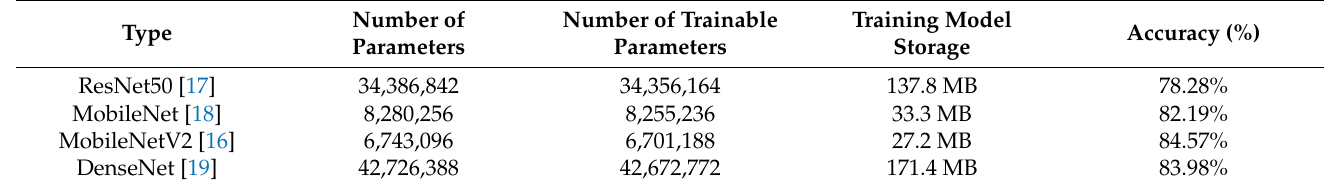
Table 1. Comparison of the experimental results of different basic networks. The networks were pretrained by the ImageNet.